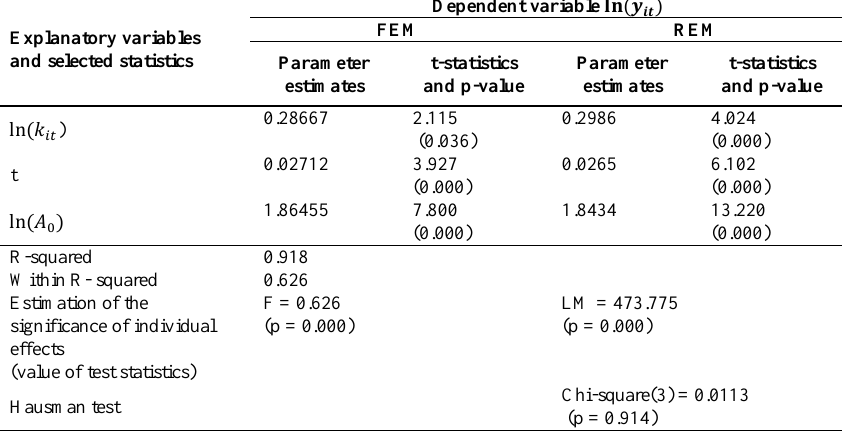
Explanatory variables and selected